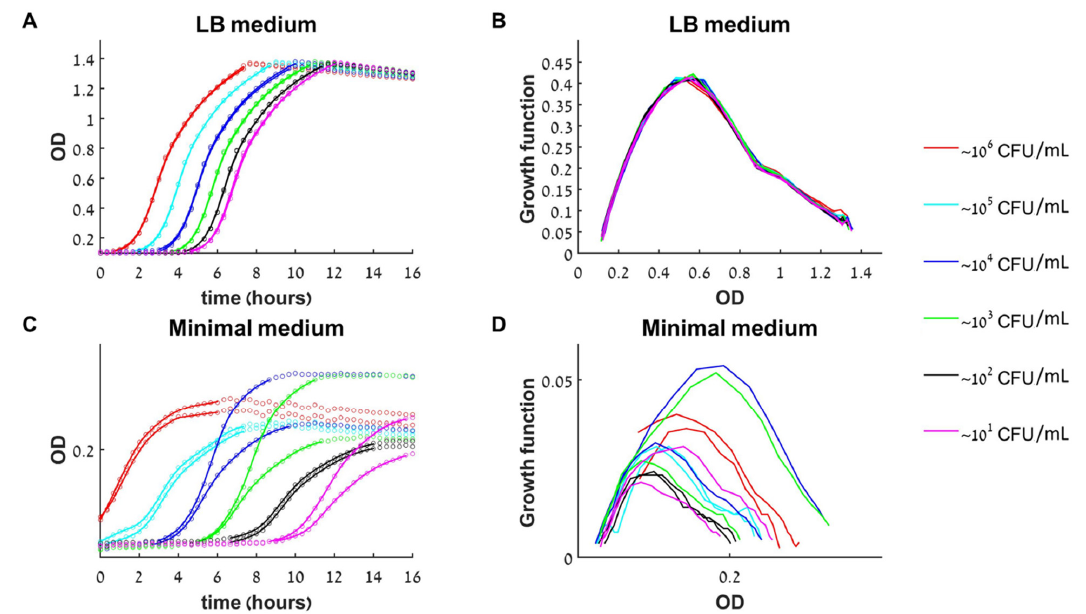
Figure 2. Growth dynamics of untreated bacteria in rich and minimal medium. ( A ) The growth of 12 initial loads (six different loads in duplicated) in rich medium (LB) as monitored by a change in optical density (OD) in time. Circles—data points, solid line—smooth approximation to data used for calculating the growth function, see methods. ( B ) The growth curves [experimental d OD /dt versus OD] collapse to a single growth function. ( C ) In minimal medium, there is high variability between duplicates and a strong influence of the initial load on the growth rate and the maximal population size. ( D ) The different growth curves in minimal medium do not collapse to a single growth function.